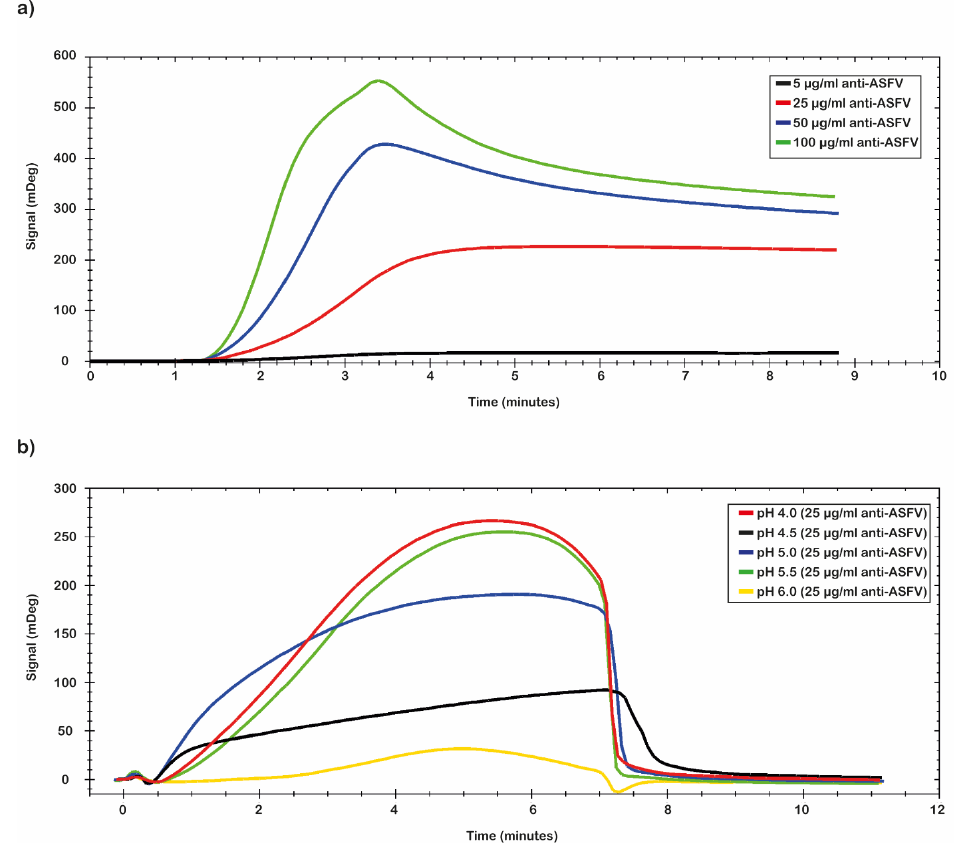
Figure 2. Pre-concentration analysis. Sensorgrams of pre-concentration scouting analysis; ( a ) the best value was obtained with the 100 µg/mL of polyclonal anti-ASFV, and the pH scouting analysis (green); ( b ) the optimal conditions of binding were obtained with the buffer at pH 5.0 (blue).